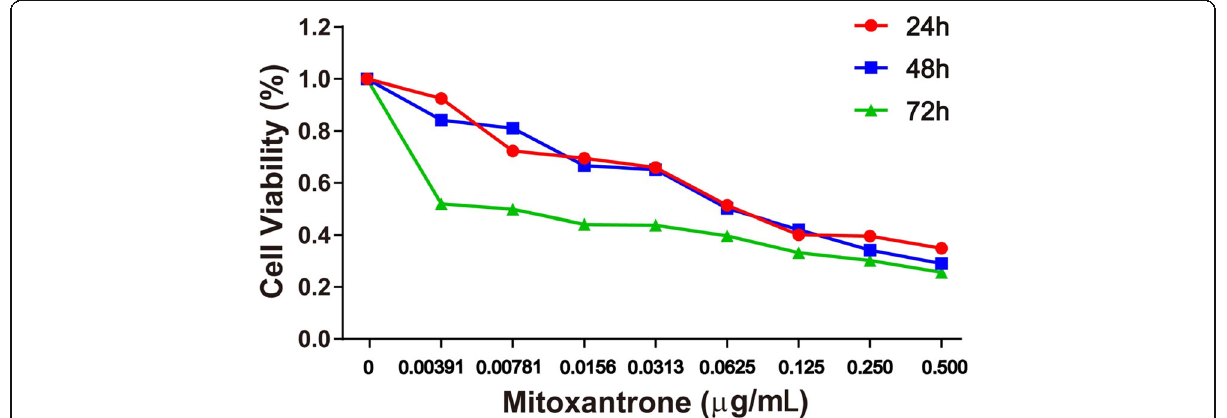
Fig. 4 Effect of treatment with mitoxantrone and NPs on cell proliferation of bladder cancer cell line MB49. Cell viability was assessed by tetrazolium- based assay with 24-, 48-, and 72-h treatment with mitoxantrone and nano-drugs from 0 to 0.5 μ g/mL on the murine bladder cancer cell line